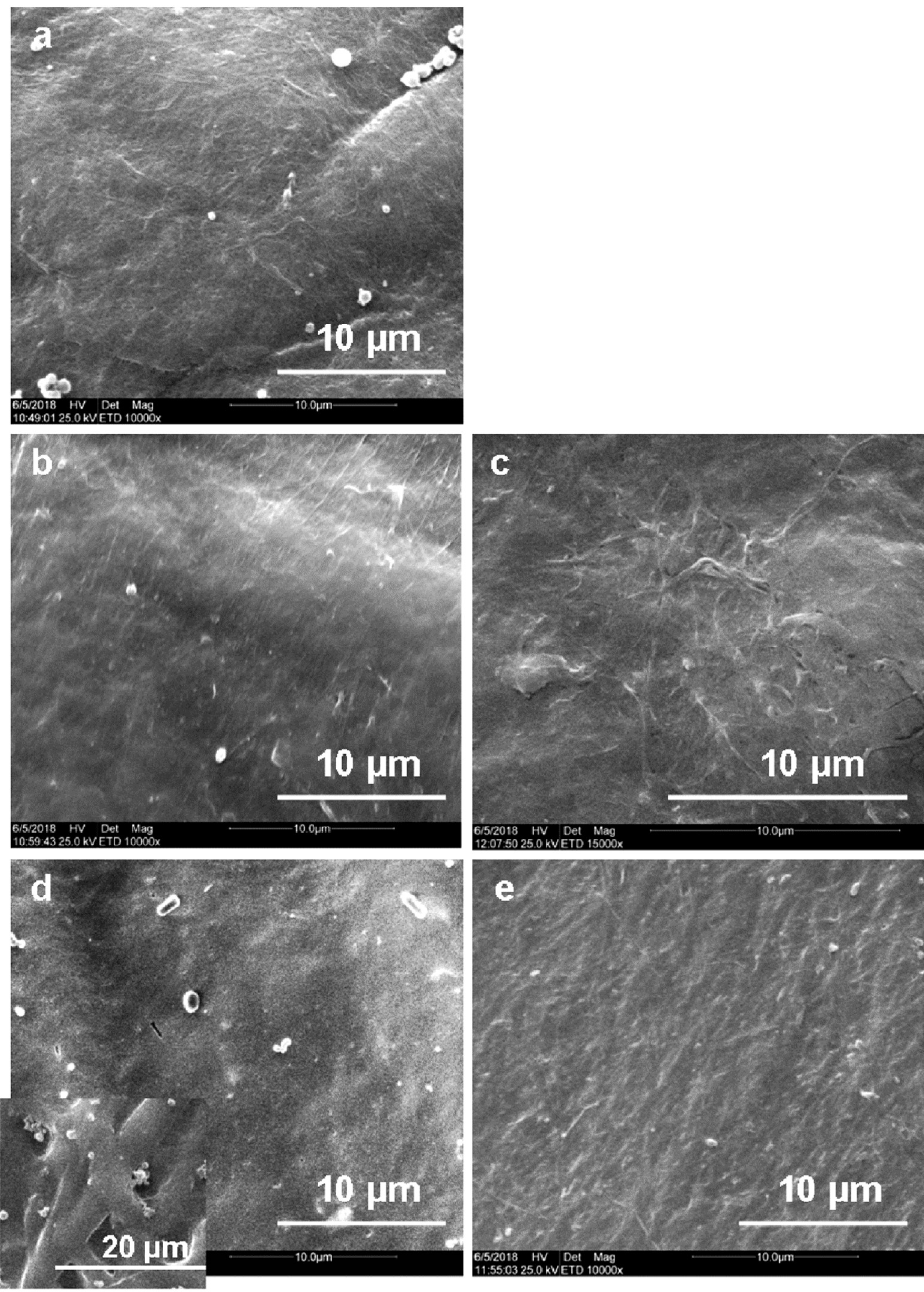
Figure 9. SEM micrographs of nanocomposites BC-PHBV ( a ), BC-Ac-PHBV ( b ), BC—AA-PHBV ( c ), BC-APS-PHBV with an inset showing the strands ( d ), BC-VS-PHBV ( e ).